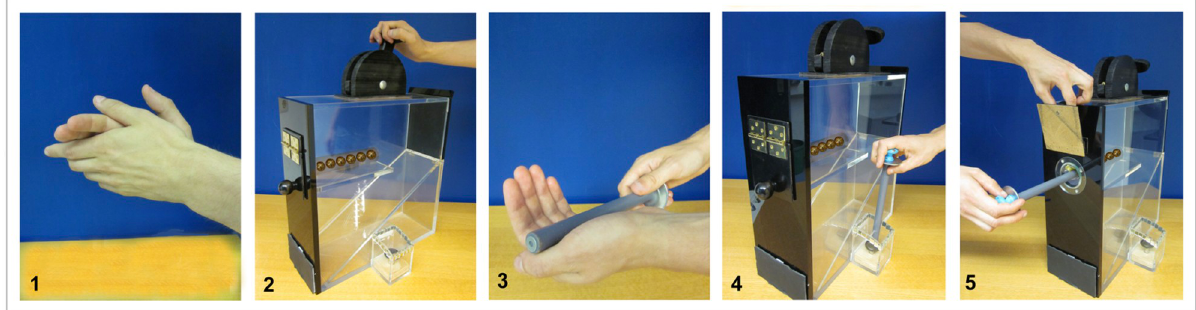
Fig 2. The demonstration of the inefficient strategy included (1) clapping, (2) pushing the lever back and forth, (3) tapping the rod into the plam of the hand three times, (4) using the rod to push the button on the side of the box and (5) inserting the magnetic rod to extract a marble. The demonstration of the efficient strategy only included (5) the insertion of the